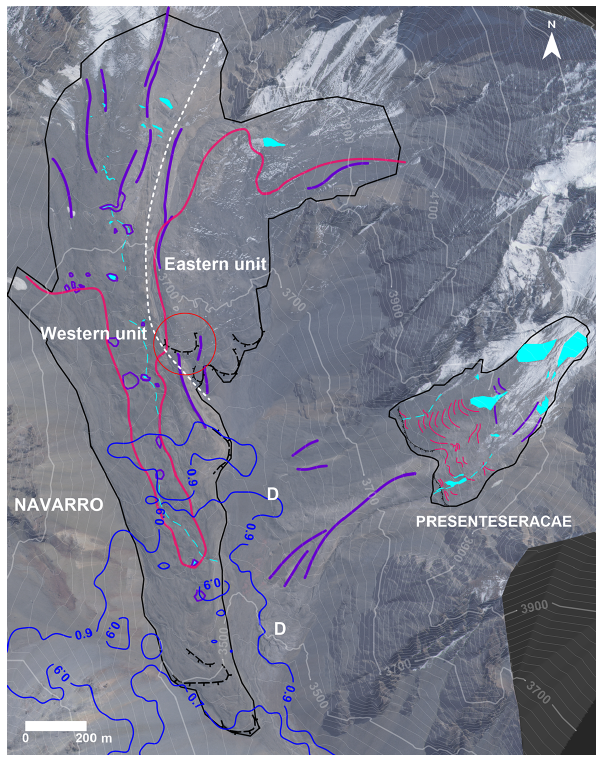
Figure 3. Map of the Navarro Valley. See Fig. 2 for legend. The background of the map is the 2014 Geoeye image draped over the Geoeye DEM (see the “Material and methods” section). Elevation contours are derived from the Geoeye DEM and the contour in- terval is 20m. The boundary between the Navarro’s western and eastern units is indicated with a dashed white line. The red circle indicates the location described in the text where morainic crests and rock glacier lobes are superimposed. Note also the decayed (D) rock glacier lobes in the area between Navarro and